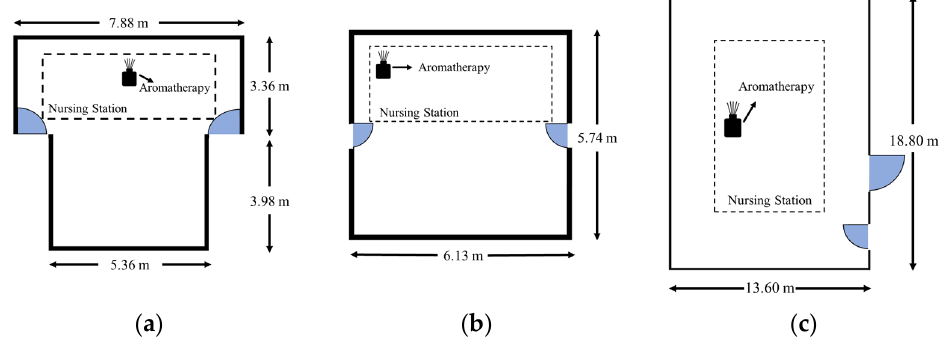
Figure 1. Layout of the nursing station in each department and the diffuser placement location: ( a ) General and palliative care department; ( b ) ObGyn department; and ( c ) ICU.